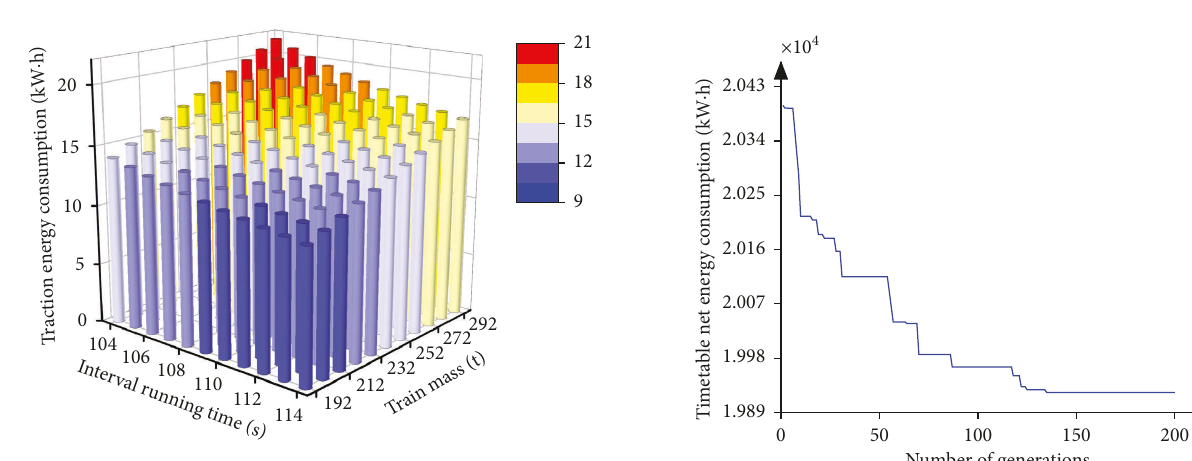
Figure 6: Traction energy consumption in the station segment 1 under different interstation running times and train masses. Table 3: Departure timetable for the time period 16: 00–19:00. Up direction departure station: Qingdao Railway Station